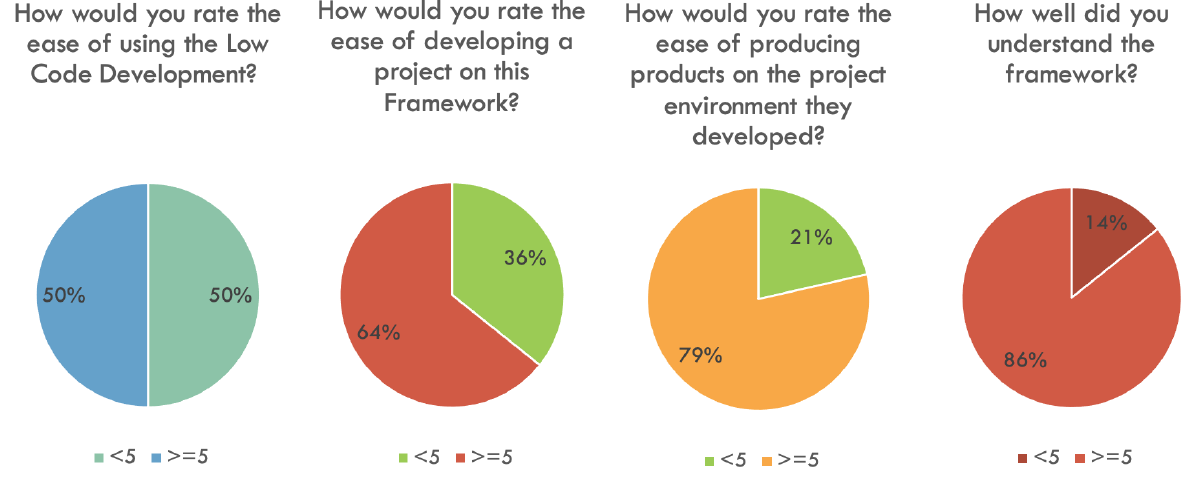
Figure 8. Easiness of the